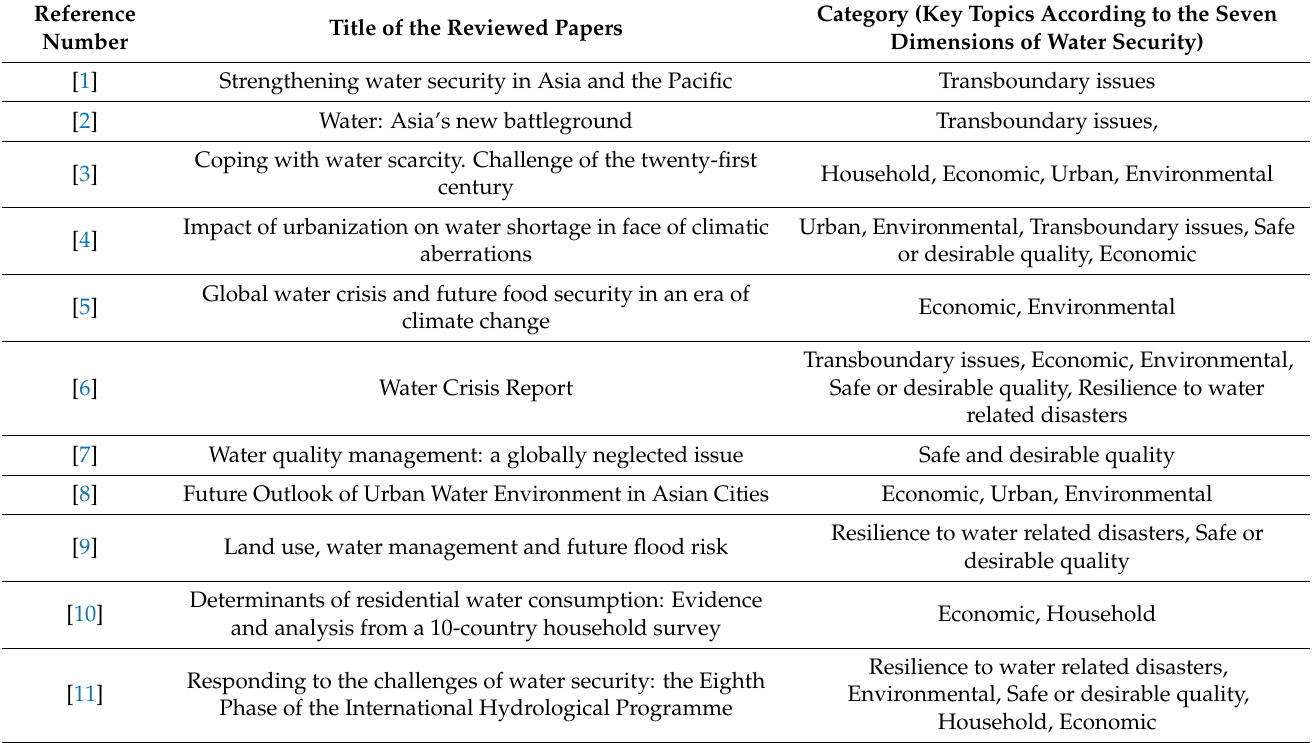
Table A1. List of reviewed papers and their relation with seven different dimensions of water security.